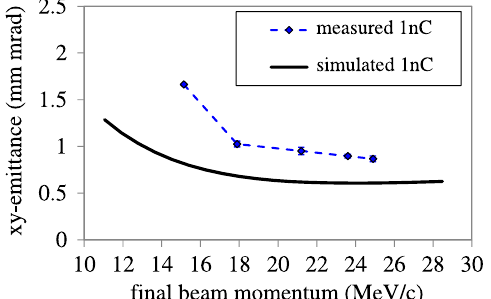
FIG. 18. Measured and simulated emittance as a function of the beam momentum after the booster. The final beam momen- tum was adjusted only by variation of the booster gradient. The rf phases of gun and booster were always tuned to MMMG phase for the experimental results.